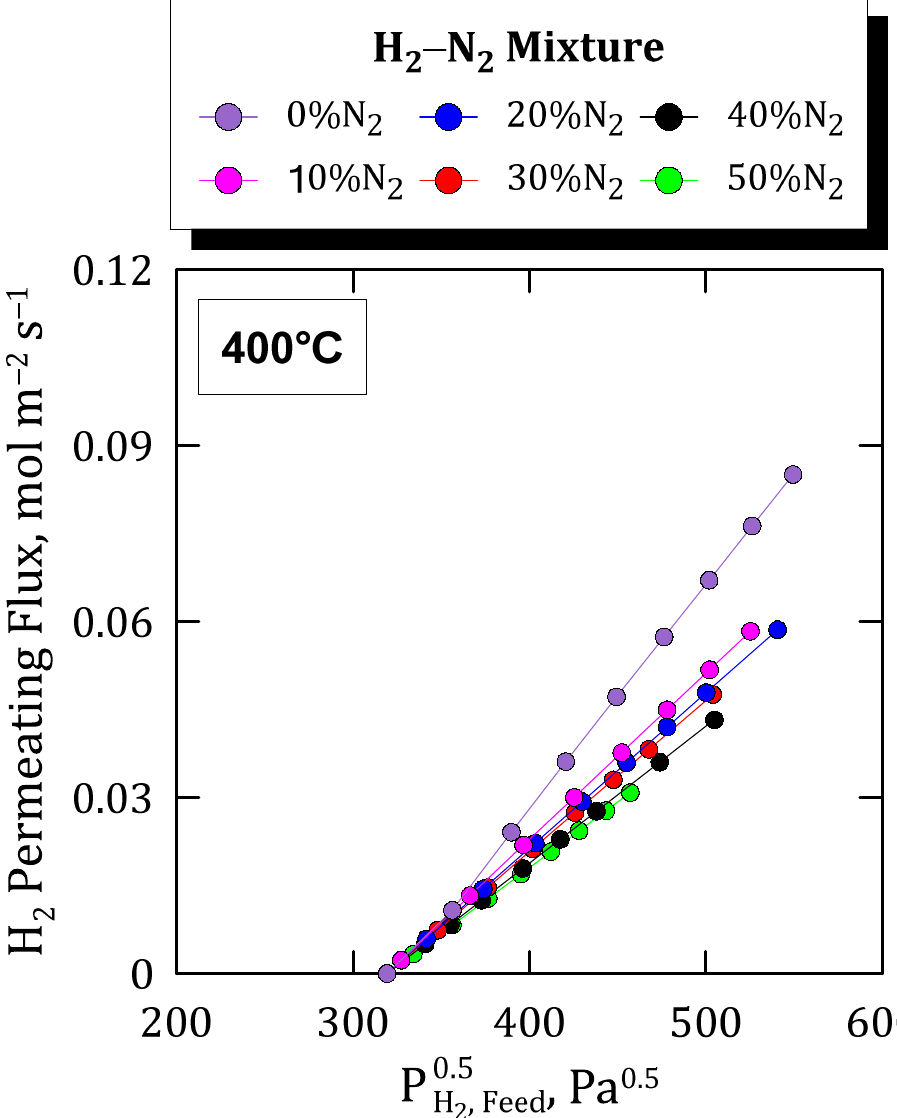
Figure 8. Hydrogen permeating fluxes for H